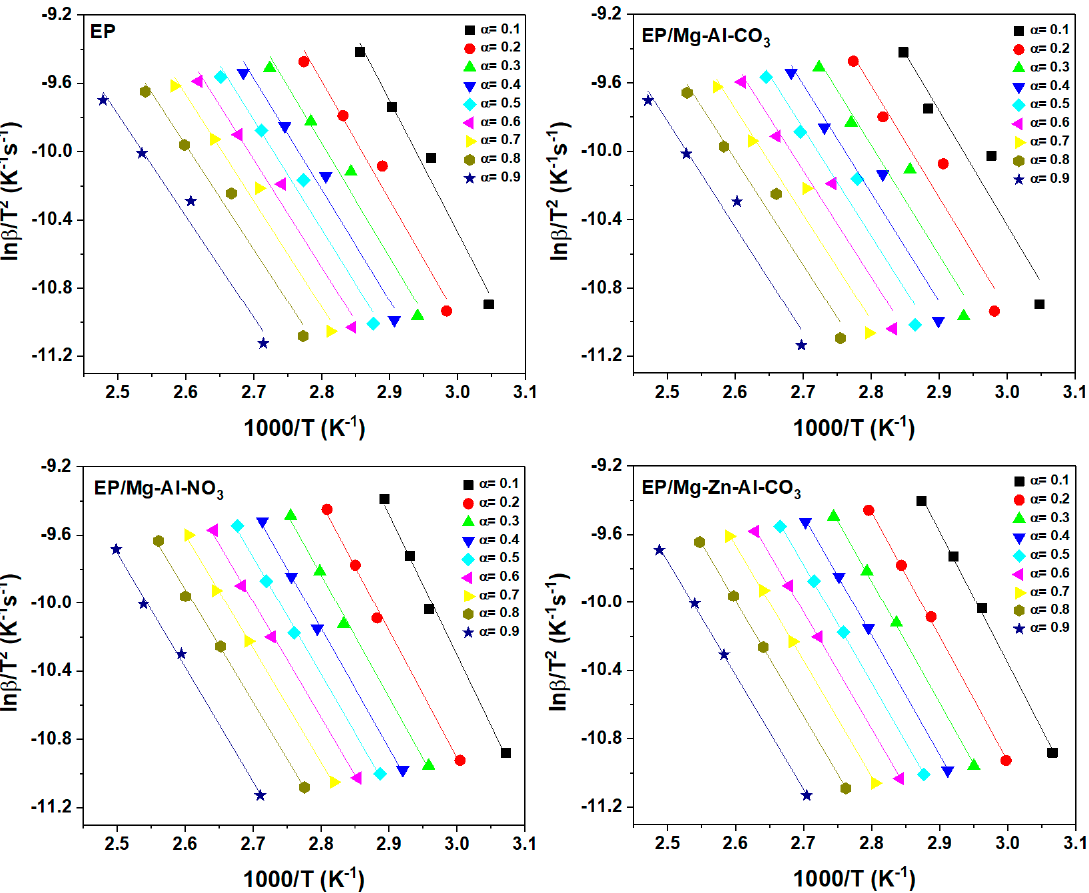
Figure A2. Plots of ln( β /T 1.92 ) vs. 1/T for the prepared samples based on the KAS